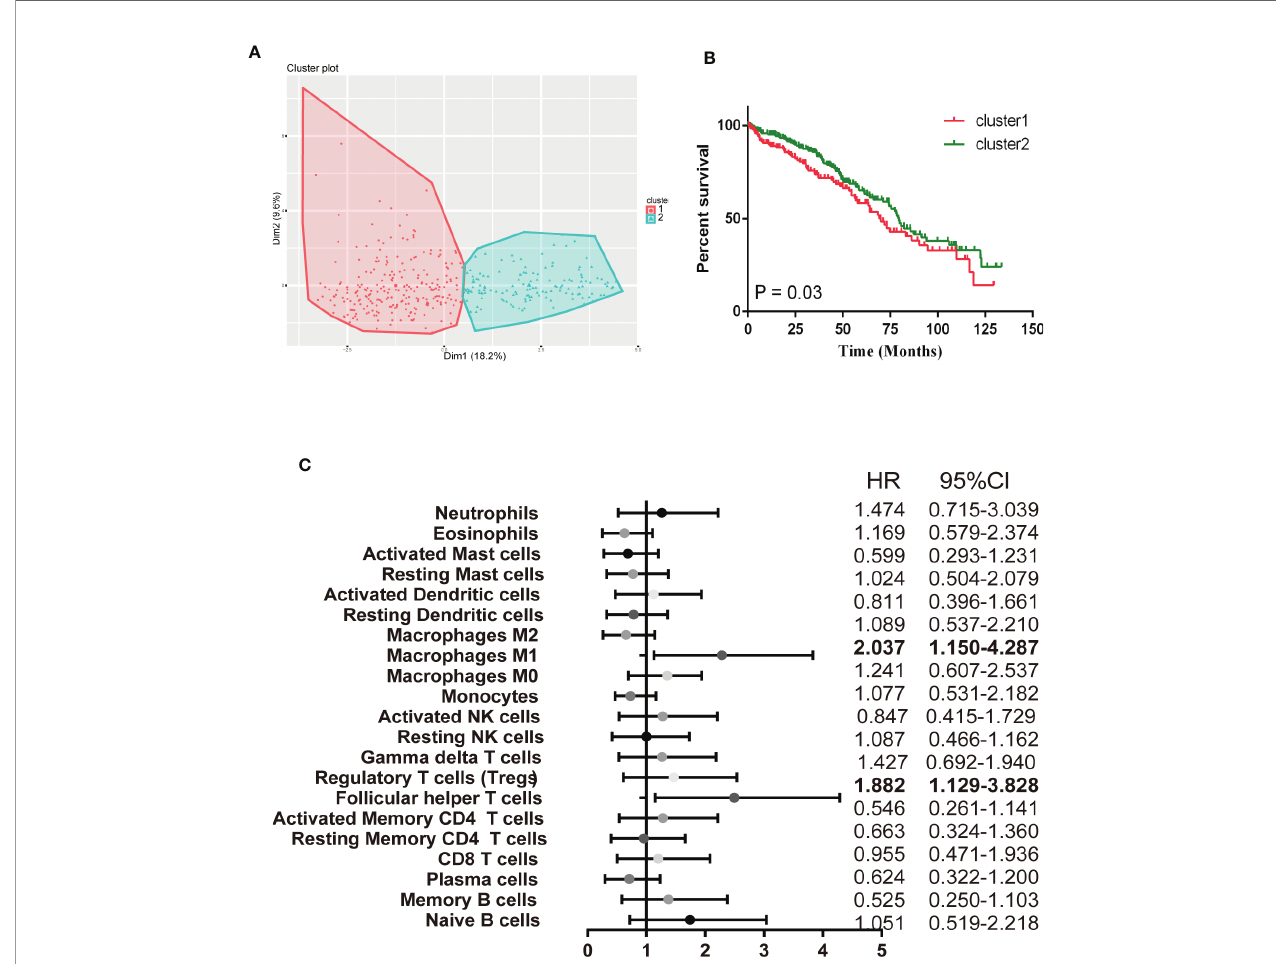
FIGURE 6 | Immune clusters associated with RCC prognosis. (A) The scatter diagram shows the variation of the principal components of each patient, according to the cohort to which they belong. (B) Kaplan-Meier survival analysis of patients within different clusters. (C) Prognostic associations of TIICs subpopulation. Unadjusted HRs (boxes) and 95% con fi dence intervals (horizontal lines) are limited to cases with CIBERSORT P -value < 0.05.